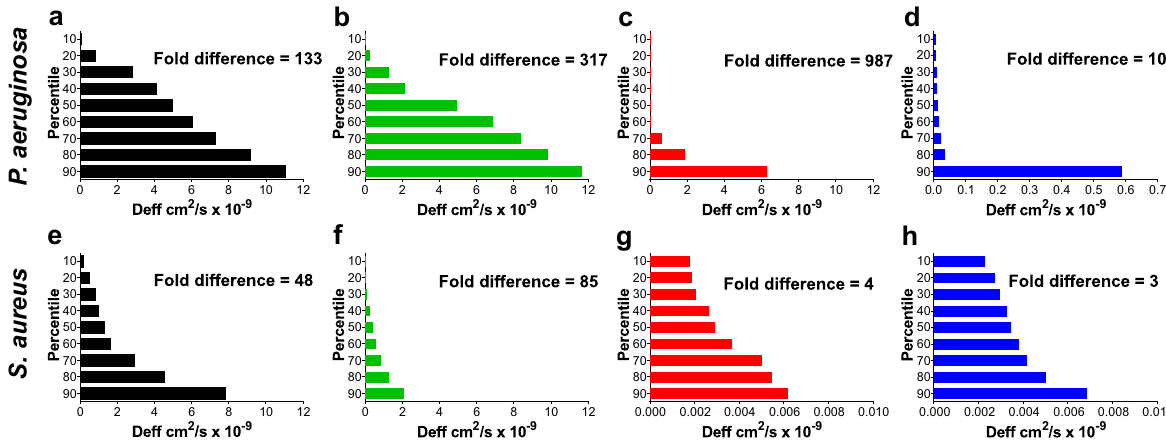
Fig. 1 Heterogeneity of NP movement through P. aeruginosa PAO1 and S. aureus 1004A (MRSA) bio fi lm structures. Heterogeneity of 40, 100, 200 and 500 nm negatively charged carboxylate-modi fi ed Fluo Sphere ® NP movement through P. aeruginosa and S. aureus bio fi lms. For each particle type, the effective diffusion coef fi cient ratio of <Deff> was calculated for 360 individual particles ( n = 3 for bio fi lm experiments, each comprised of 120 particles) over a time interval of 20s and then data was ranked into percentiles from the 90th through to 10th percentile. a , e Negatively charged 40 nm carboxylate-modi fi ed Fluo Sphere ® in P. aeruginosa and S. aureus bio fi lms, respectively; b , f negatively charged 100nm carboxylate-modi fi ed Fluo Sphere ® in P. aeruginosa and S. aureus bio fi lms, respectively; c , g negatively charged 200nm carboxylate- modi fi ed Fluo Sphere ® in P. aeruginosa and S. aureus bio fi lms, respectively; d , h negatively charged 500 nm carboxylate-modi fi ed Fluo Sphere ® in P. aeruginosa and S. aureus bio fi lms, respectively. Fold difference in the fi gure indicates the fold difference between the 90th and 10th percentiles.